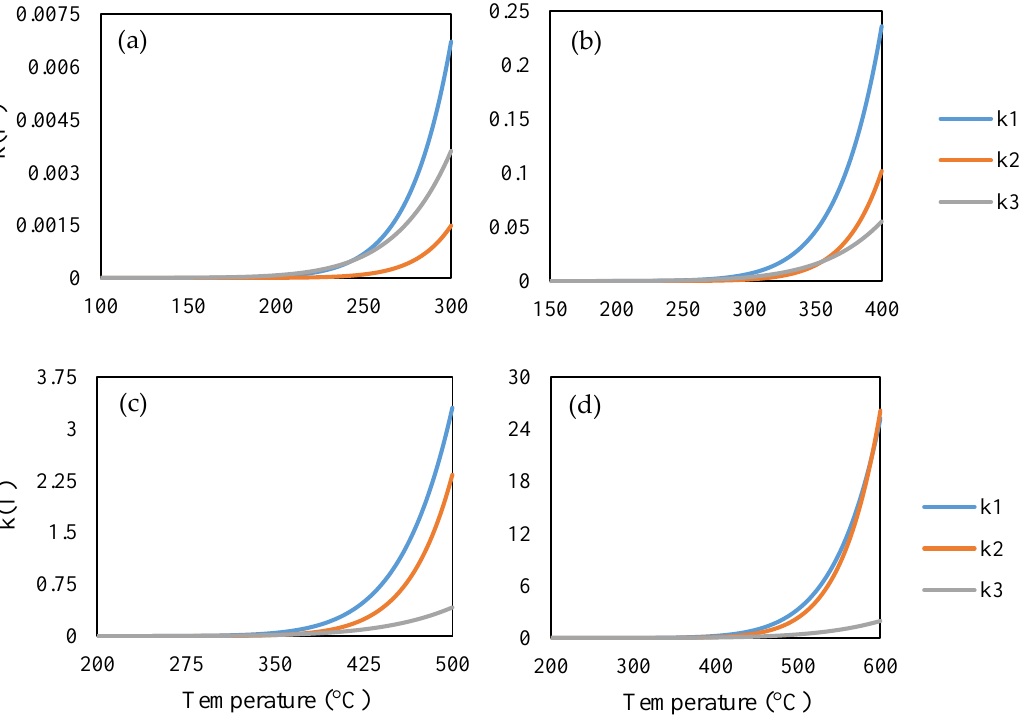
Figure 6. The reaction rate constants (s − 1 ) versus temperature (K): ( a ) for the temperature range 100 ◦ C to 300 ◦ C; ( b ) for the temperature range 150 ◦ C to 400 ◦ C; ( c ) for the temperature of range 200 ◦ C to 500 ◦ C; and ( d ) for the temperature range 200 ◦ C to 600 ◦